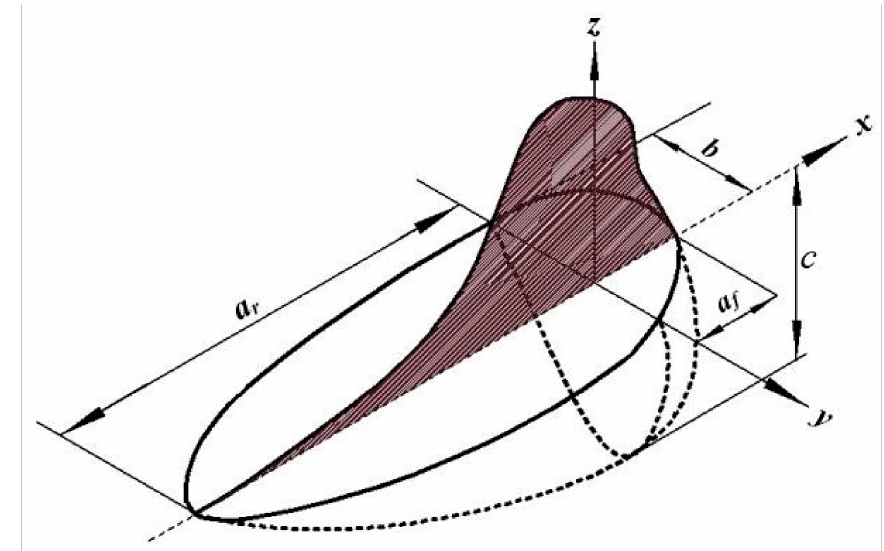
Figure 4. The double ellipsoidal heat source